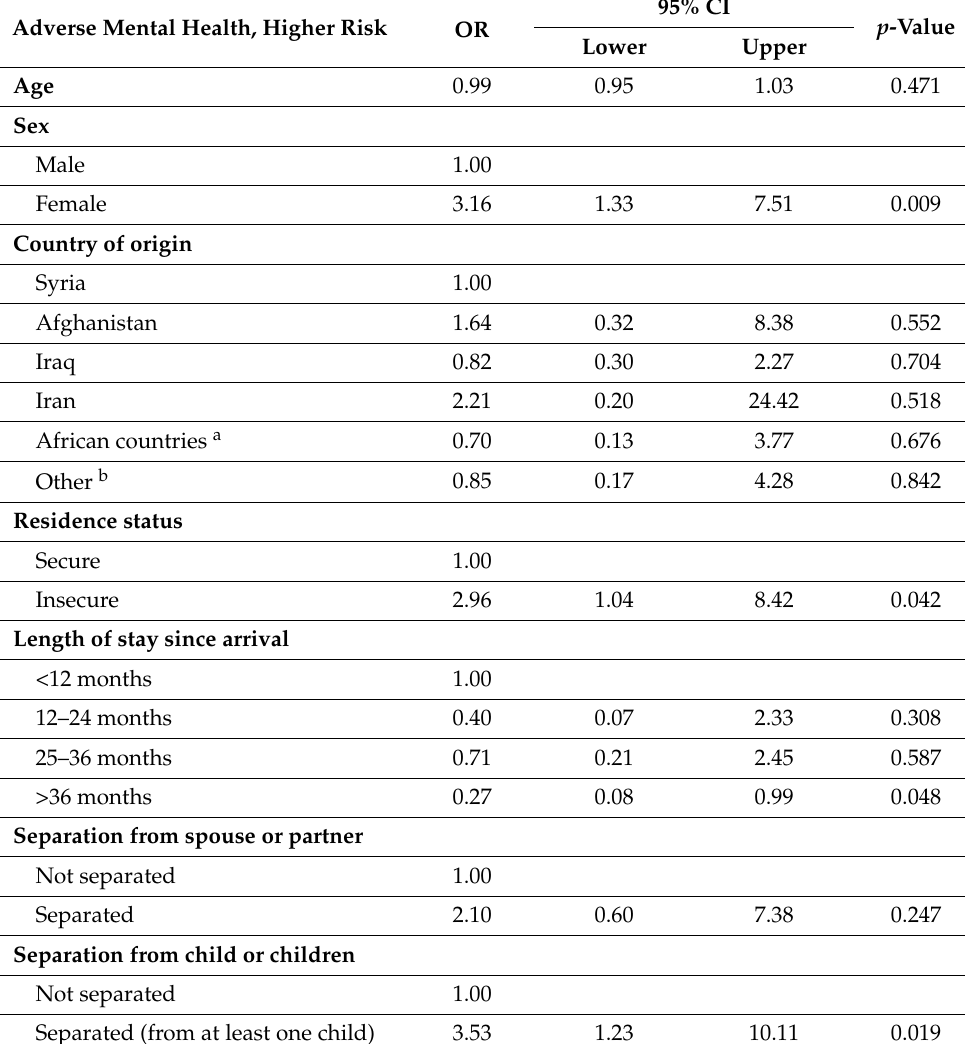
Table 4. Results of logistic regression analysis on predictors for higher risk for adverse mental health, n =